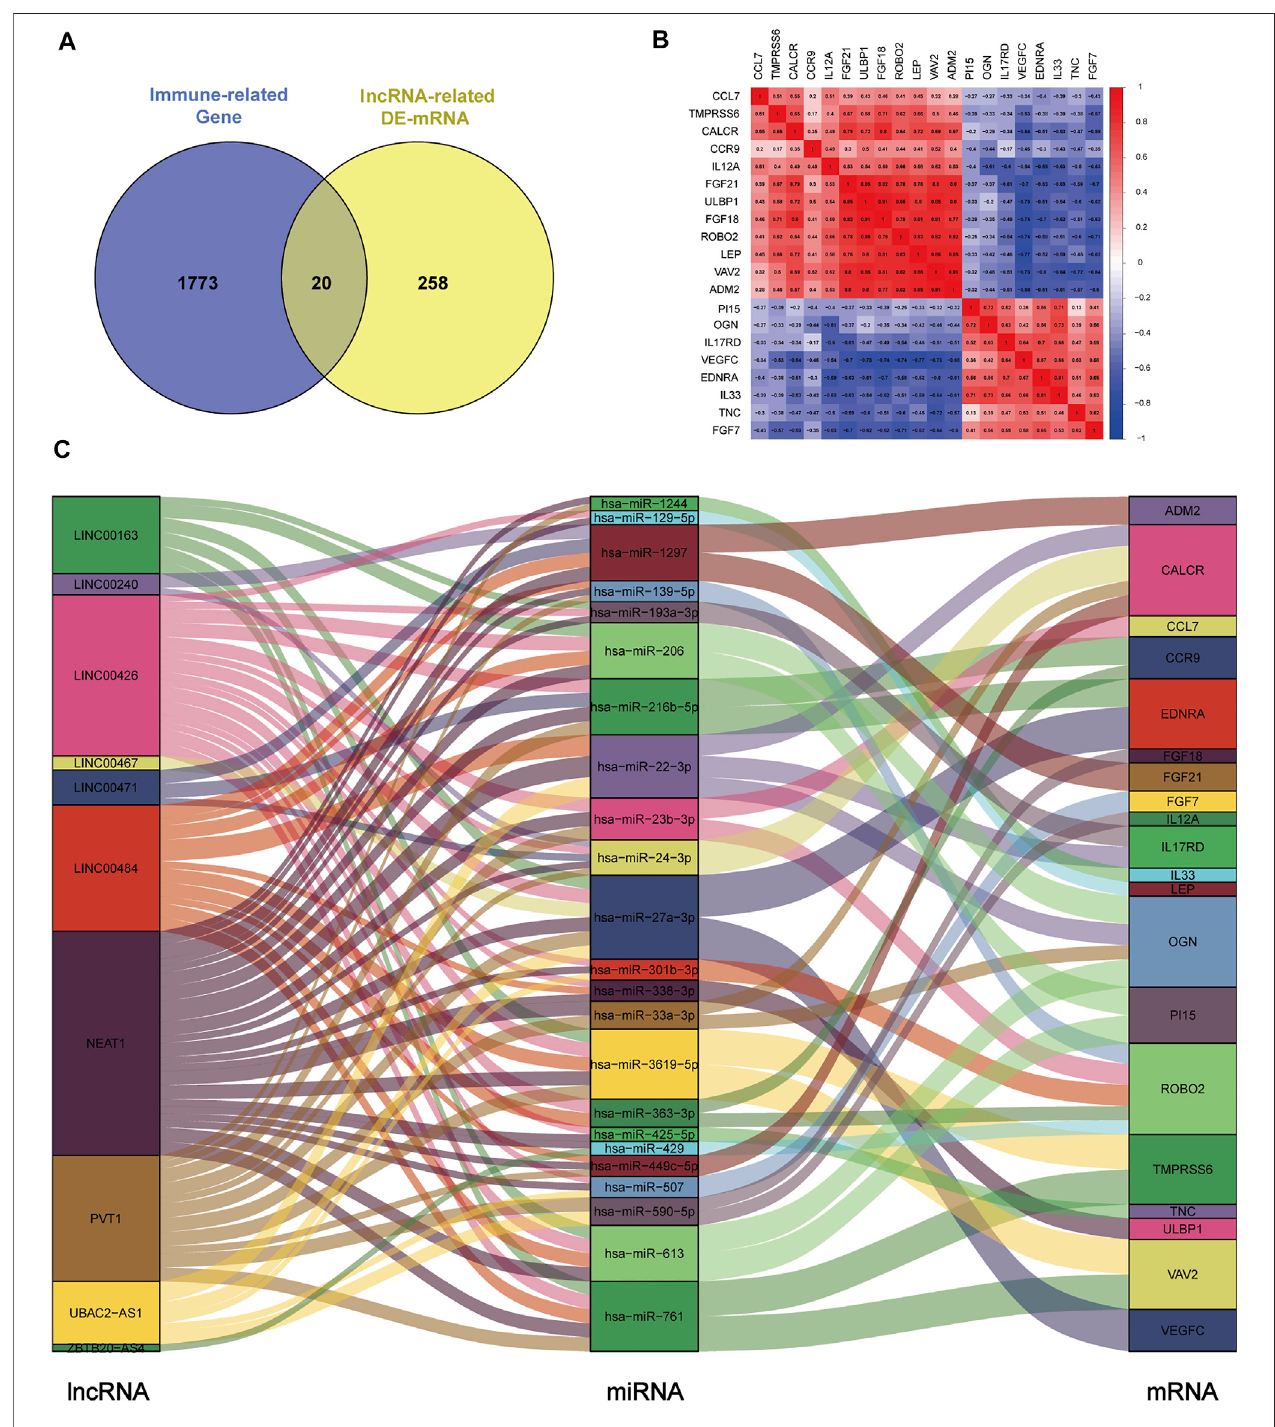
FIGURE 4 | Construction of immune-related ceRNA network in kidney stones. (A) Intersection between lncRNA-related DE-mRNAs and immune-related genes. (B) Co-expression analysis of immune-related DE-mRNAs. (C) Immune-related ceRNA regulatory network.